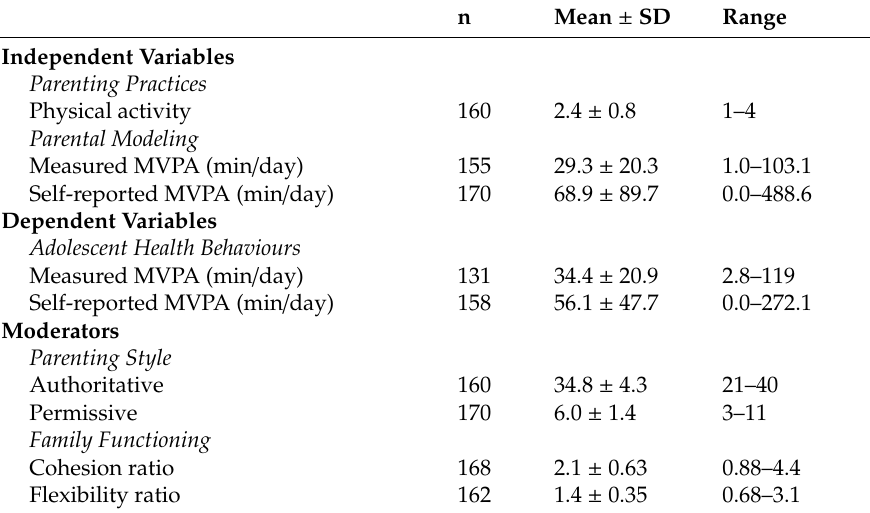
Table 3. Description of variables in